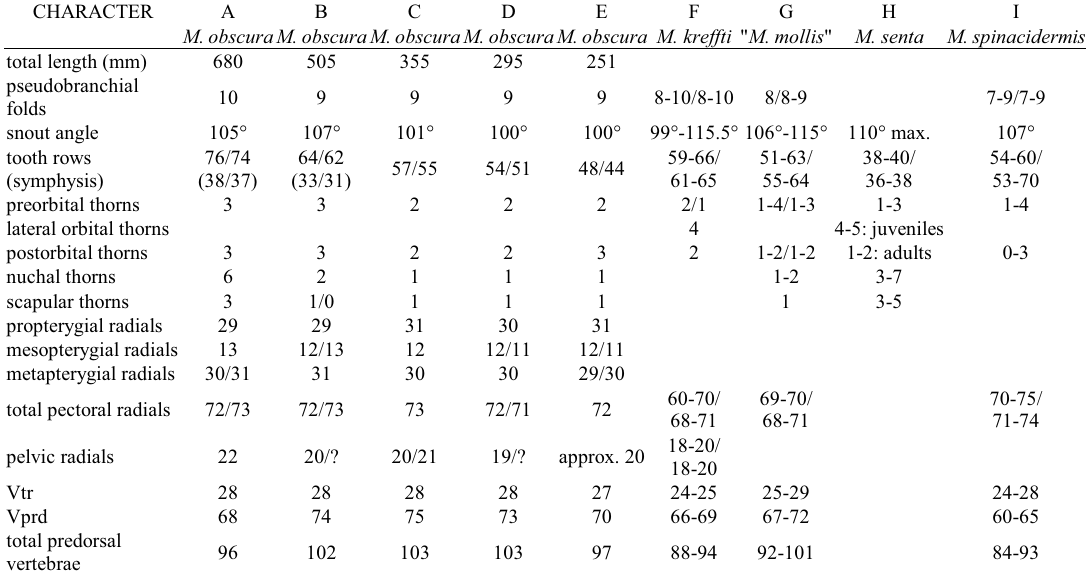
Table 2. Meristic data for all specimens of M . obscura (A–E corresponds to specimens as in Table 1) and other species of Malacoraja (compiled from the literature). Left/right values are shown when these differ. F: M . kreffti ; data from Stehmann (1993). G: “ M . mollis ”; data from Templeman (1965), Krefft & Lübben (1966), Hulley (1970), and Stehmann (1977). H: M . senta ; data from Bigelow & Schroeder (1953) and McEachran (2002). I: M . spinacidermis ; data from Hulley (1970), Stehmann (1977), Hulley & Stehmann (1977), and Stehmann